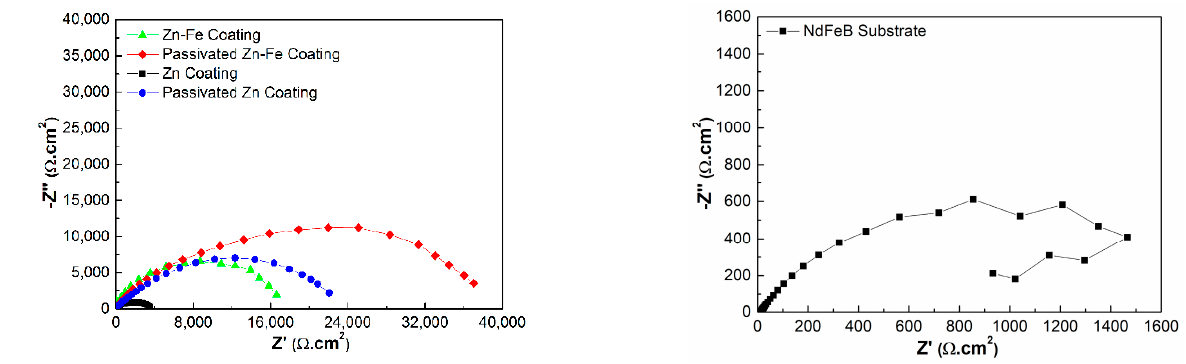
Figure 7. Nyquist impedance plots of different specimens in neutral 3.5 wt.% NaCl solution.